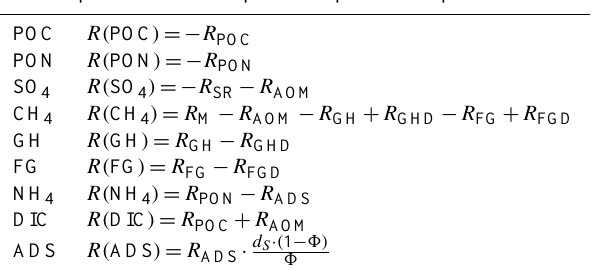
Table A3. Summary of the rate expressions of the specific species used for the differential equation system.